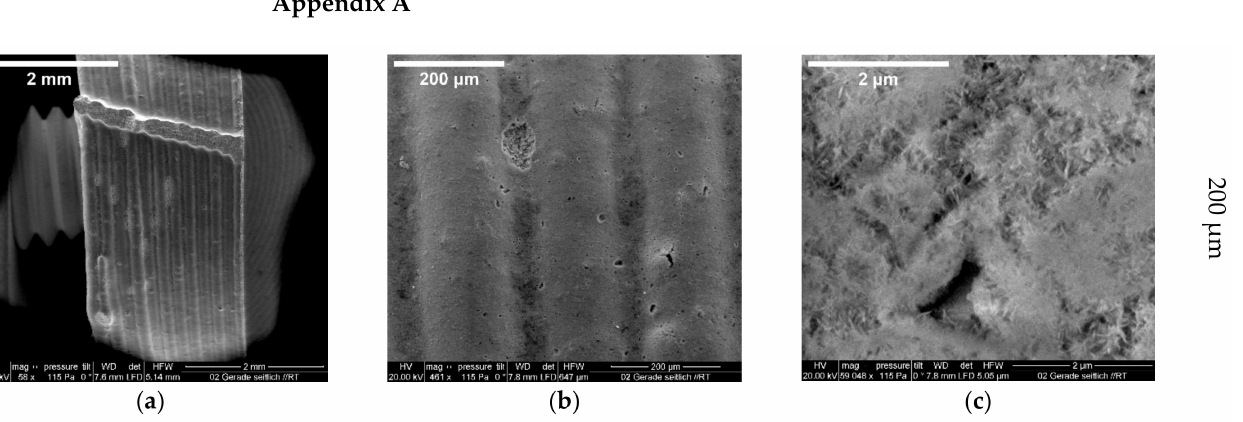
Figure A1. ESEM images of 200 µ m straight spoke scaffold from the side at a fracture site. Magnified images (increasing magnification from ( a – c )) show the scaffold from the side with the individual planes; accelerating voltage: 20 kV, vacuum: 114 Pa, large field detector.